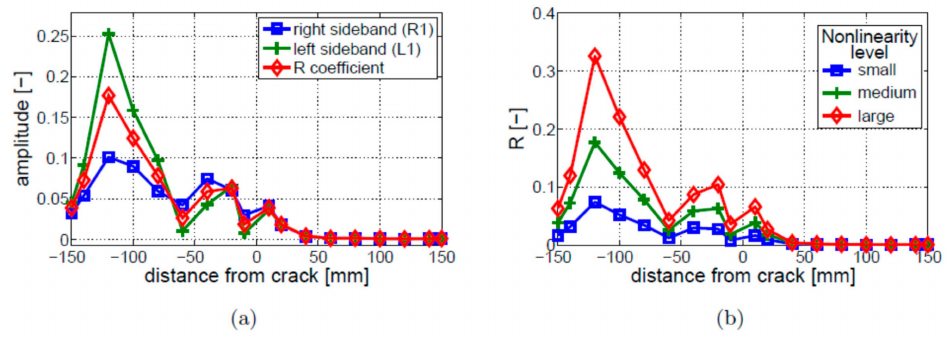
Figure 7. Parametric study of nonlinear vibro-acoustic modulations for the bi-linear crack model: ( a ) modulation intensity; ( b ) crack depth. Small, medium, and large nonlinearity levels correspond to three different crack depths modeled using the stress–strain curves given in Figure 3.